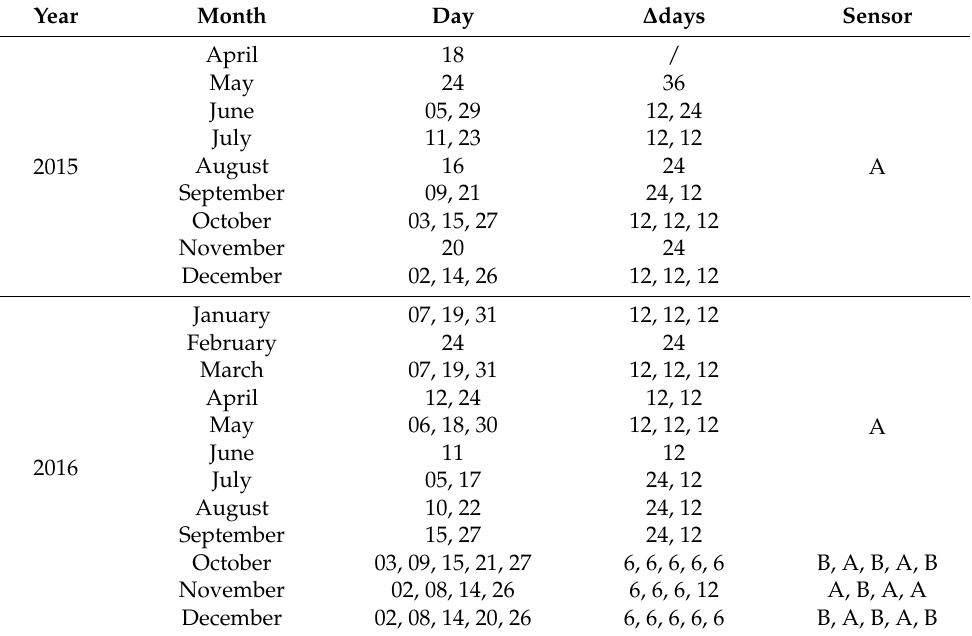
Table 1. Sentinel-1A/1B acquisitions used in this